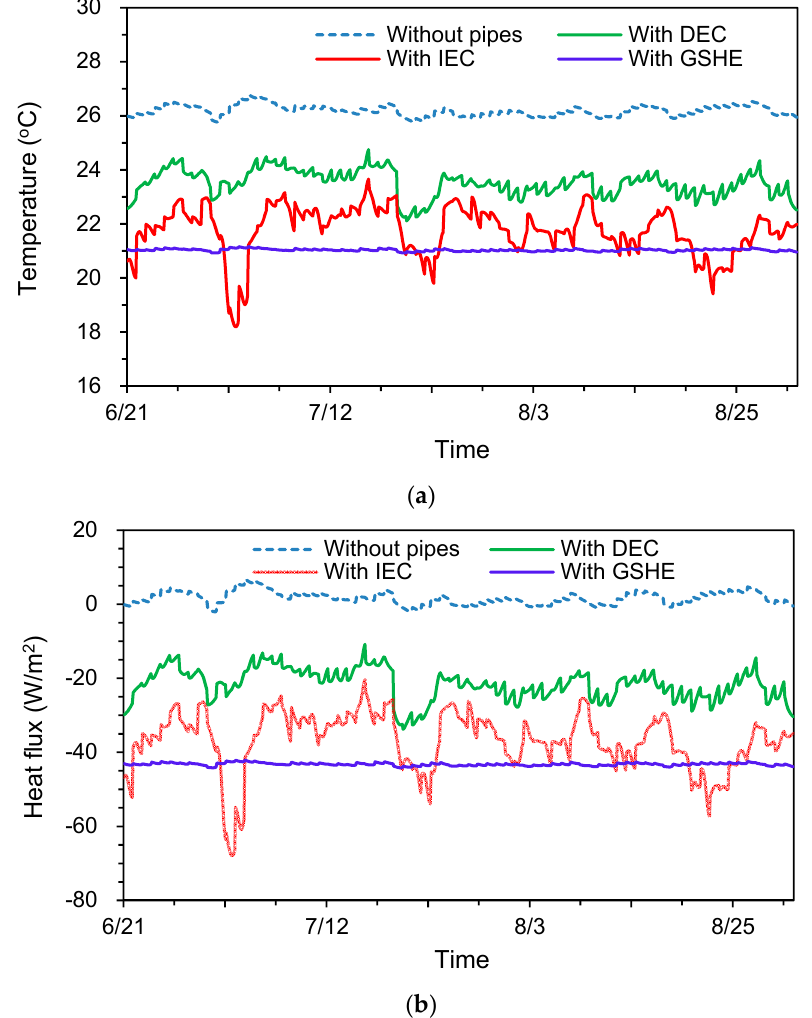
Figure 10. Heat transfer in different walls: ( a ) Temperature variation; and ( b ) Heat flux variation.